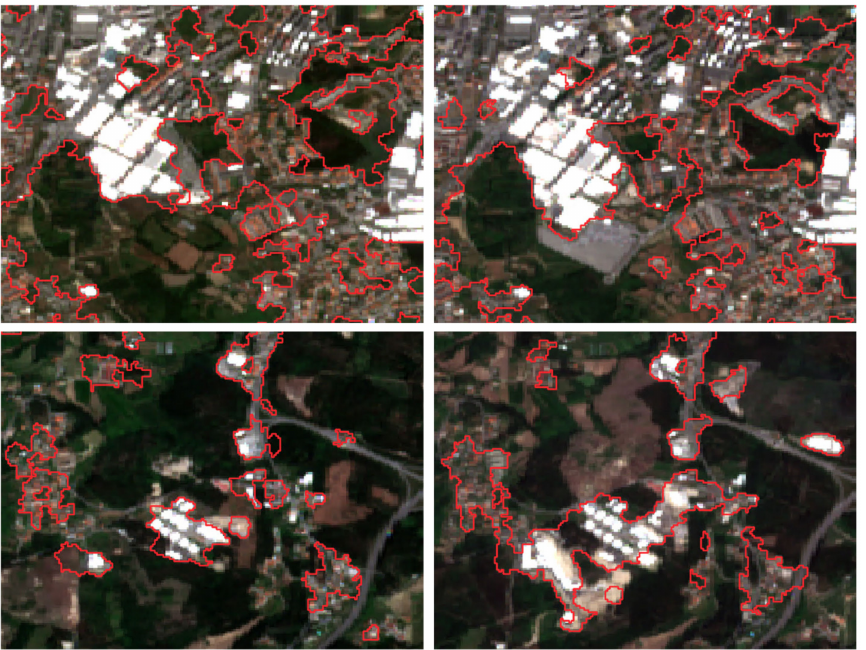
Figure 14. Examples of urban areas borders for two different periods ( left : 2017, right :